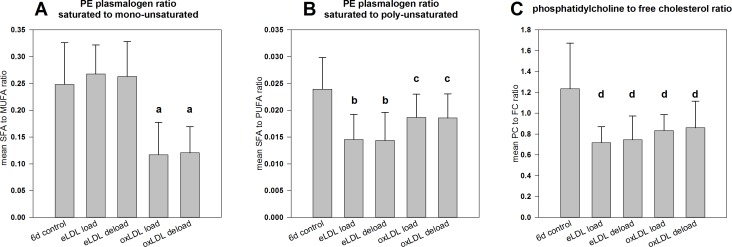
Estimation of membrane fluidity by calculation of lipid ratios on day six.(A) The ratios of saturated to mono-unsaturated PE P species and (B) of saturated to poly-unsaturated PE Ps were calculated as markers for membrane fluidity in control and treated cells on day six. Additionally the mean PC to FC ratio was determined (C). Means +/- SD, n = 9 for control and deload measurements and n = 8 for loaded cells; (a: p<0.001 against control and eLDL loaded cells, b: p<0.001 against control cells, c: p<0.05 against controls, d: p<0.01 against controls).